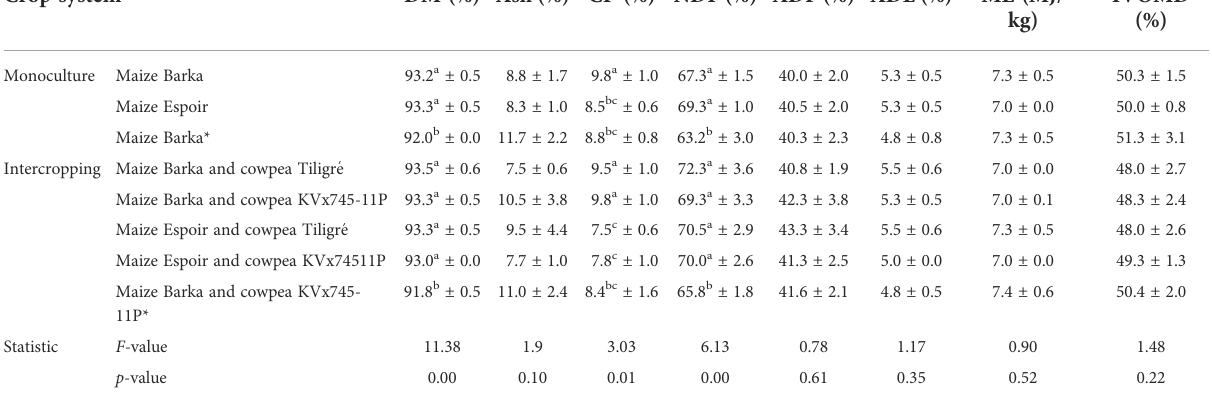
TABLE 10 Nutritive value of maize stover as affected by cropping systems in on-station and on-farm trials. Crop system